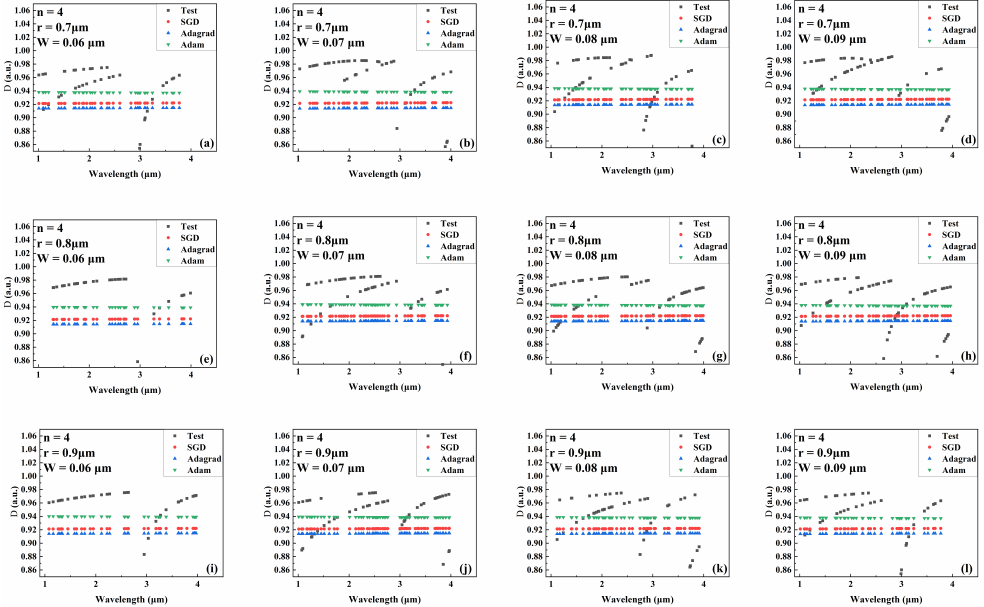
Figure 13. Comparison the predicted and actual values of D in the test data set of the network model trained by different optimizers for different combinations of core radius and cantilever width (number of cantilevers: 4). ( a ) r = 0.7 µ m, W = 0.06 µ m. ( b ) r = 0.7 µ m, W = 0.07 µ m. ( c ) r = 0.7 µ m, W = 0.08 µ m. ( d ) r = 0.7 µ m, W = 0.09 µ m. ( e ) r = 0.8 µ m, W = 0.06 µ m. ( f ) r = 0.8 µ m, W = 0.07 µ m. ( g ) r = 0.8 µ m, W = 0.08 µ m. ( h ) r = 0.8 µ m, W = 0.09 µ m. ( i ) r = 0.9 µ m, W = 0.06 µ m. ( j ) r = 0.9 µ m, W = 0.07 µ m. ( k ) r = 0.9 µ m, W = 0.08 µ m. ( l ) r = 0.9 µ m, W = 0.09 µ